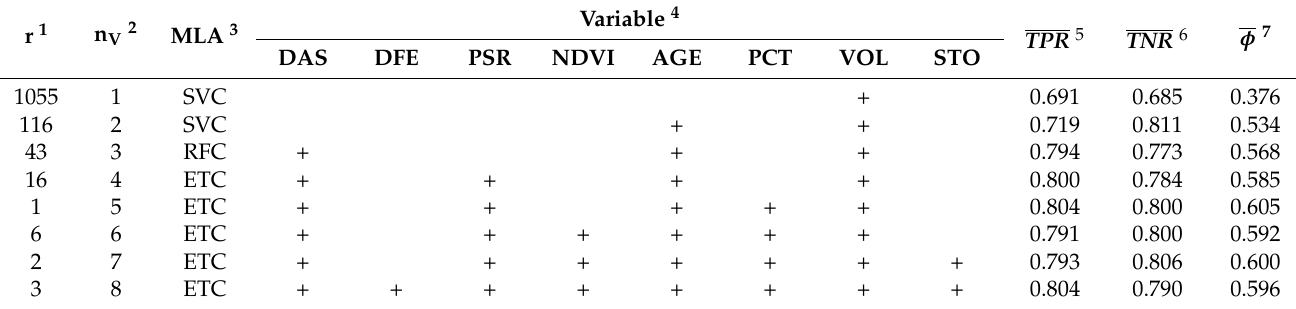
Figure 7. Box plots of mean specificities ( TNR ) of FDMs generated by MLAs. Box plots show median plus upper and lower quartiles for mean specificities of all FDMs generated by a given algorithm. Minimum and maximum values are indicated by the upper and lower whiskers (1.5 × interquartile range). Circles are outliers. See Table 3 for MLA codes. Table 6. Top FDMs among models with equivalent numbers of explanatory